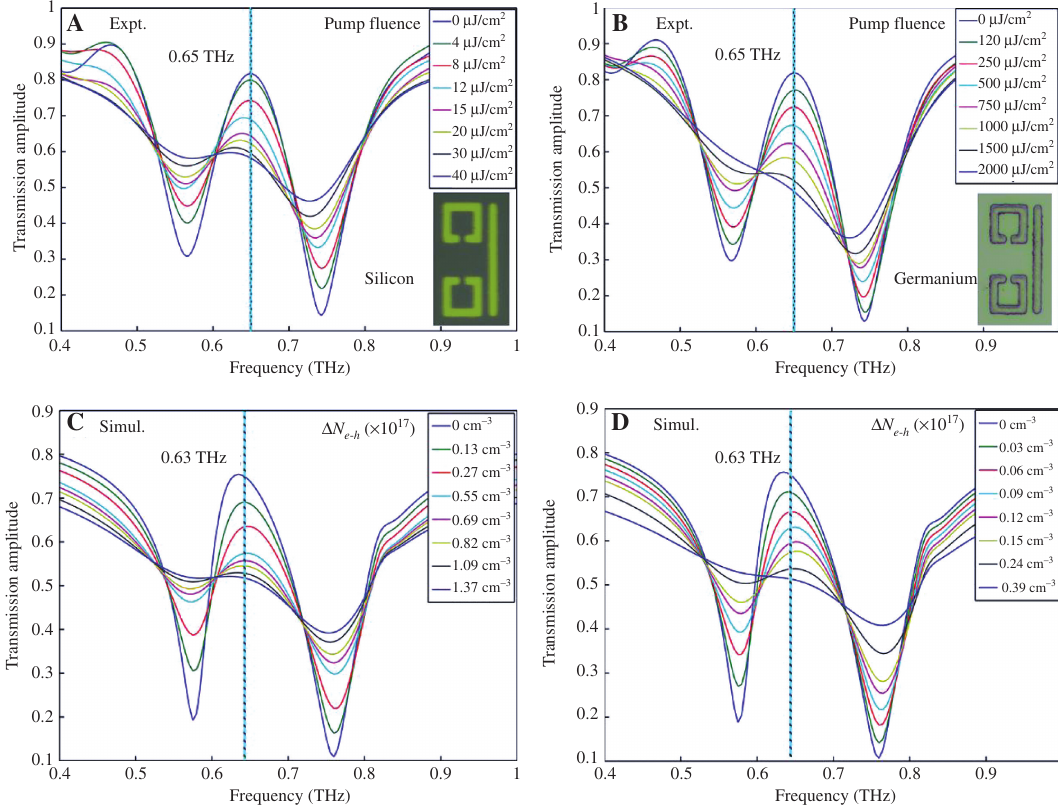
Figure 3: Normalized results of the all-optical modulation in amplitude transmissions spectra. Optically pump-power-controlled active tuning of the transmitted amplitude of EIT window at 0.65 THz is achieved by changing the photoconductivity of (A) Si and (B) Ge films. The corresponding numerically simulated transmission results are shown in (C) and (D), respectively, as a function of photoexcited carrier density ∆ N . The insets in (B) and (A) are the microscopic images of the front and back e-h surfaces of a unit fabricated metamaterial on the sapphire substrate. The dashed line represents the EIT frequency of resonance